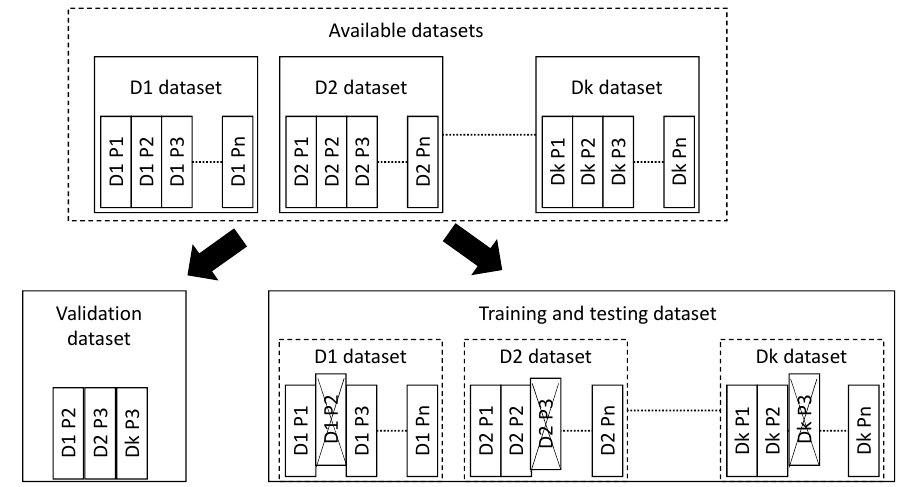
Figure 3. Cross-validation scheme. From the available datasets ( D x ), some participants ( P y ) (and all of their TS) are preserved for validation purposes. The remaining participants and their TS are all conforming to the training and validation